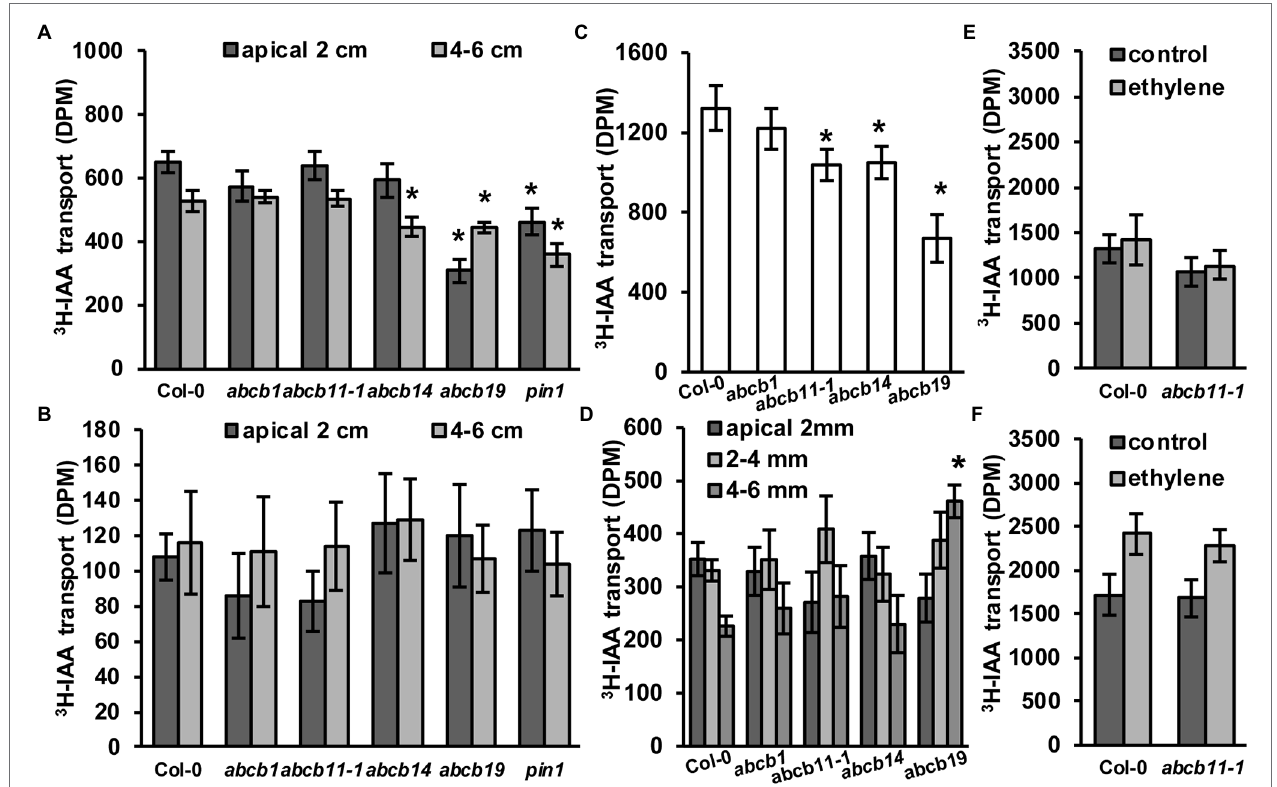
FIGURE 7 | abcb11-1 mutants exhibit minor defects in root auxin transport. (A,B) 3 H-IAA transport in (A) upright (rootward/basipetal) and (B) inverted Col-0, abcb1 , abcb11 , abcb14 , abcb19 , and pin1 inflorescence stems segments. Assays were conducted as in Kaneda et al. (2011) with modifications as noted in the Materials and Methods section. Data shown are means ± SD ( n = 3 pools independent of five segments). (C,D) 3 H-IAA transport in Col-0, abcb11 , abcb14 , and abcb19 seedlings from the shoot apex to (C) the root–shoot transition zone (RSTZ) or (D) the root tip. Data shown are means ± SD ( n = 3 independent pools of 10). (E,F) Shootward auxin transport from the root tip with 3 H-IAA placed on the (E) columella or (F) quiescent center. Shootward assays were conducted as in Kubeš et al. (2012). Data shown are means ± SD ( n = 3 independent pools of 10). Asterisks indicate statistical difference from Col-0 by Student’s t -test (* p < 0.05).